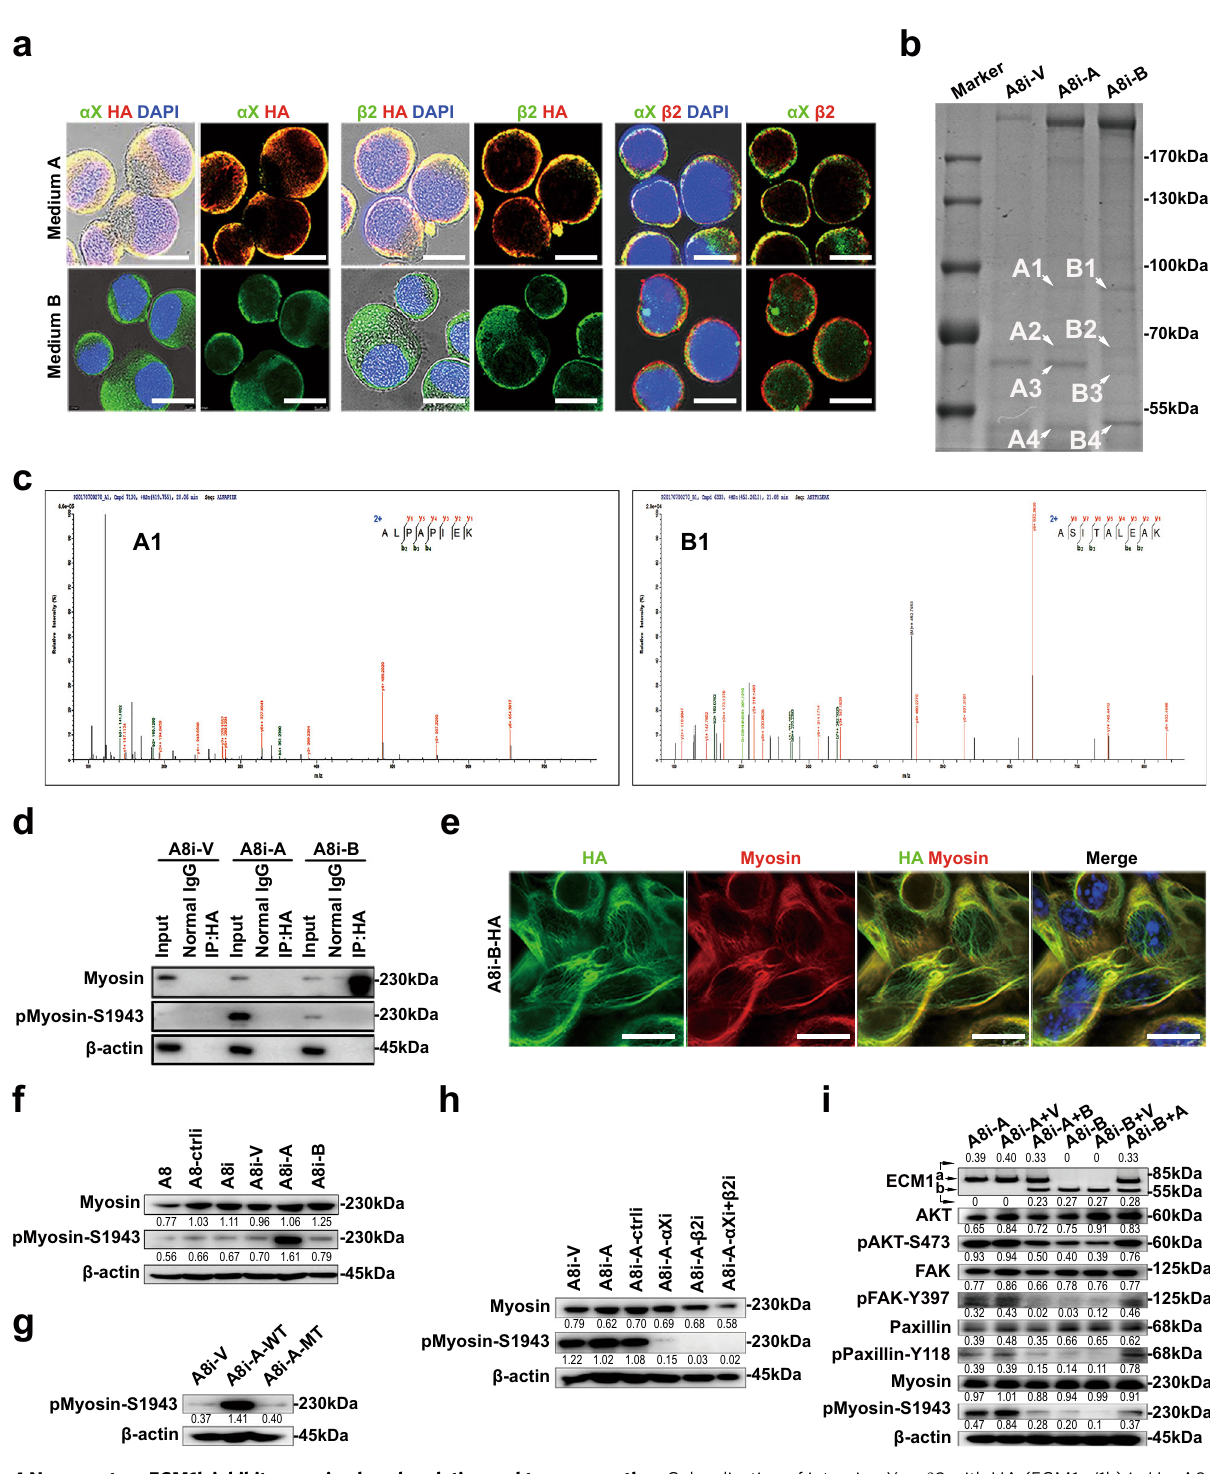
Fig. 4 Nonsecretory ECM1b inhibits myosin phosphorylation and tumor growth. a Colocalization of integrin α X or β 2 with HA (ECM1a/1b) in HeyA8 cells treated with medium A and B collected from A8i-A and A8i-B cells, respectively (bars = 10 µ m). b Coomassie Brilliant Blue (R-250) staining of co-IP products prepared with cell lysates (CLs) of A8i-A and A8i-B cells and an anti-HA antibody after separation by SDS-PAGE; the arrows indicate the protein bands analyzed by mass spectrum (MS). c Results of secondary ion MS analyses of the most abundant proteins in A1 and B1 samples derived from ECM1a and ECM1b, respectively. d Direct binding of ECM1a or ECM1b to nonphosphorylated and phosphorylated myosin IIa detected by co-IP and WB analysis using corresponding antibodies. e Colocalization of ECM1b with nonphosphorylated myosin IIa detected by IF in cells (bar = 10 µ m). Expression of myosin IIa and phosphorylated myosin IIa detected by WB analysis in ECM1-silenced cells and ECM1a- and ECM1b-overexpressing cells ( f ), in WT and MT ECM1- overexpressing cells ( g , the actin loading control in g was also used for the same samples in Fig. 3f left panel because these tests were parallelly performed), in integrin α X- or integrin β 2-knockdown cells ( h ), and in ECM1a cells (A8i-A) transfected with ECM1b (A8i-A + B) or ECM1b cells (A8i-B) transfected with ECM1a (A8i-B + A) ( i